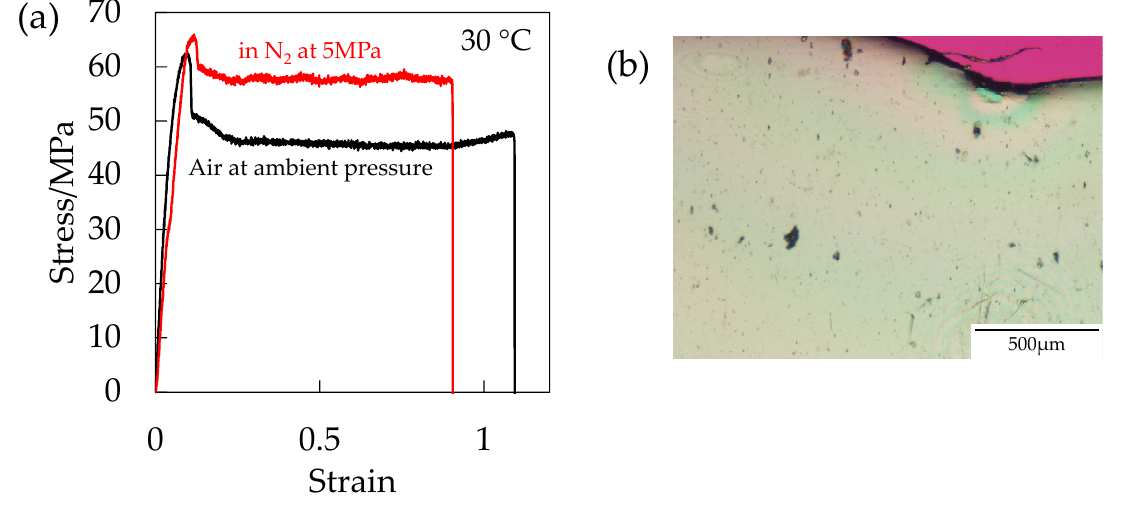
Figure 14. ( a ) Stress–strain curve of OD-PC under N 2 at 5 MPa and under air at atmospheric pressure; ( b ) polarized optical micrographs of OD-PC obtained by stretching under N 2 at 30 °C.